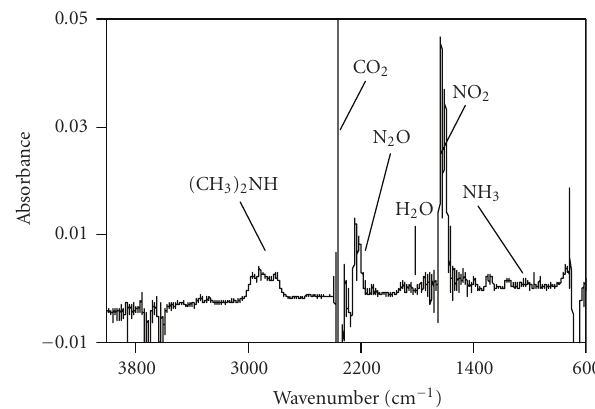
Figure 1: FT-IR spectrum of the outlet flow during PCO of DMA at a contact time of 4.5